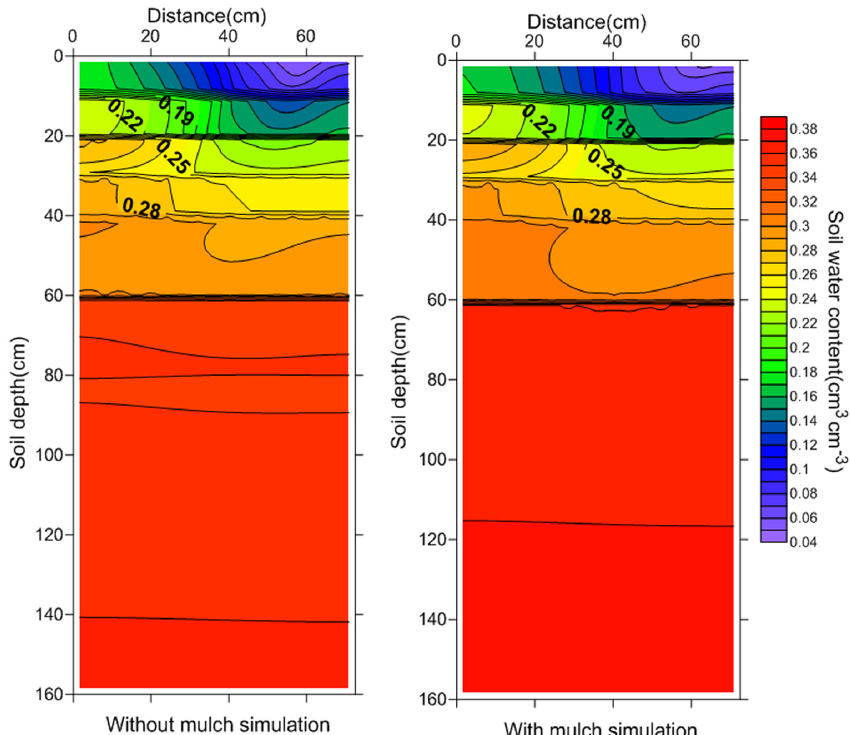
Figure 8. Average soil water contents simulated during the growing season under the two scenarios ( i.e. , with/without mulch cover).